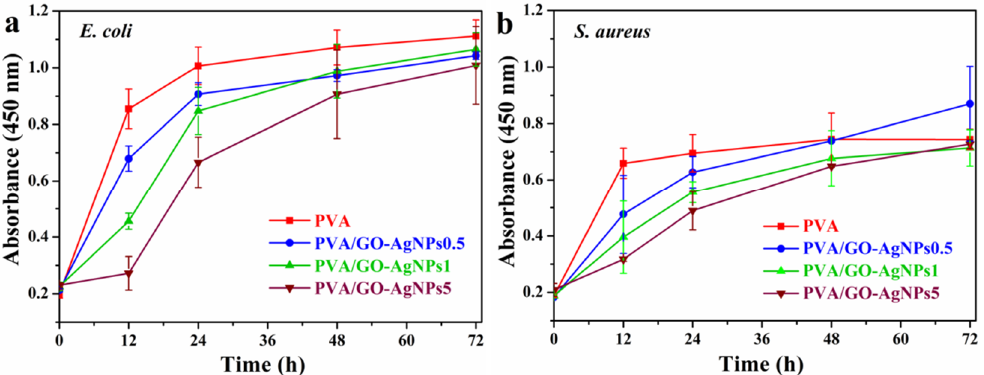
Figure 9. Absorbance of ( a ) E. coli growth curves and ( b ) S. aureus growth curves after different times